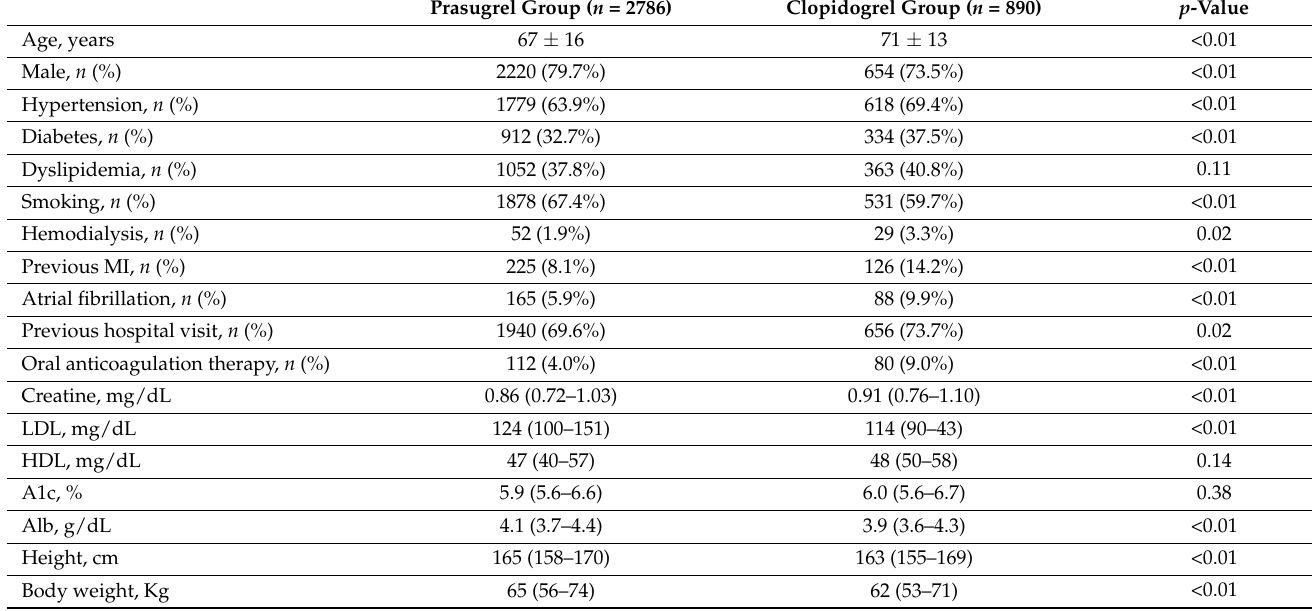
Table 1. Patient characteristics.